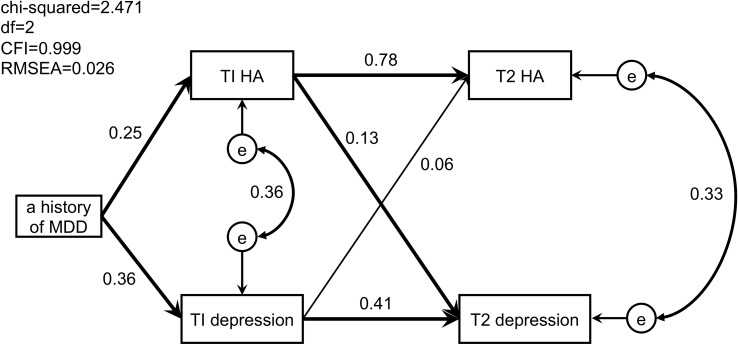
Path model of perinatal depressive symptoms, harm avoidance, and a history of major depressive disorder. Significant paths are in bold. T1, during pregnancy; T2, at 1 month postpartum; MDD, major depressive disorder; HA, harm avoidance; e, error.